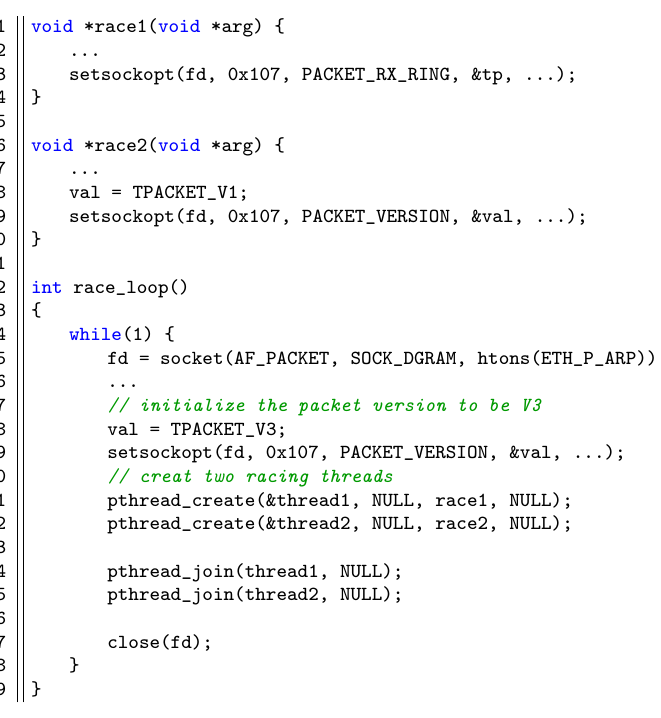
Figure 2. A PoC code fragment of kernel race vulnerability, CVE-2016-8655